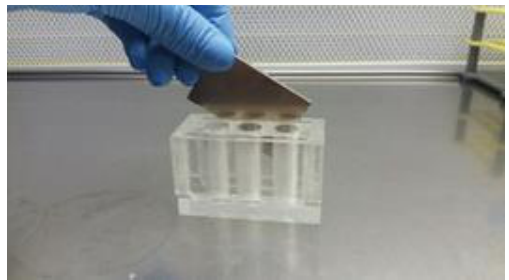
Figure 1. Plexiglass acrylic rack with 6 Eppendorf tubes’ places, equipped with commercial NdFeB permanent magnets.